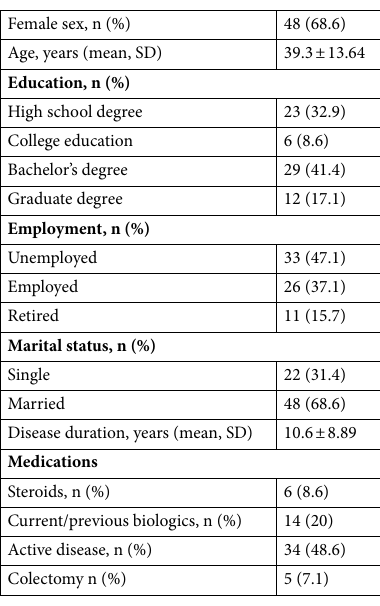
Table 1. Patient and disease characteristics of 70 consecutive patients with ulcerative colitis. SD, standard deviation.